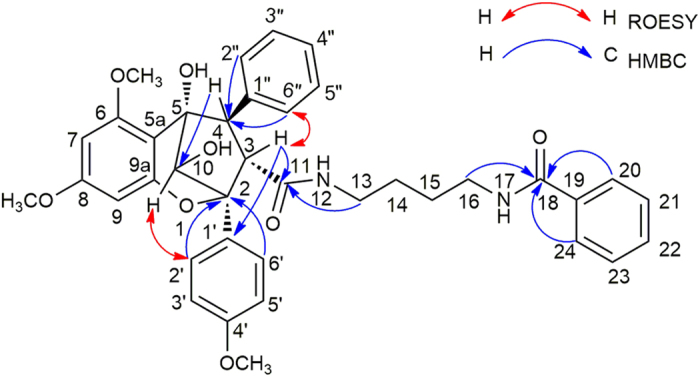
Selected key HMBC and ROESY correlations observed for 2.